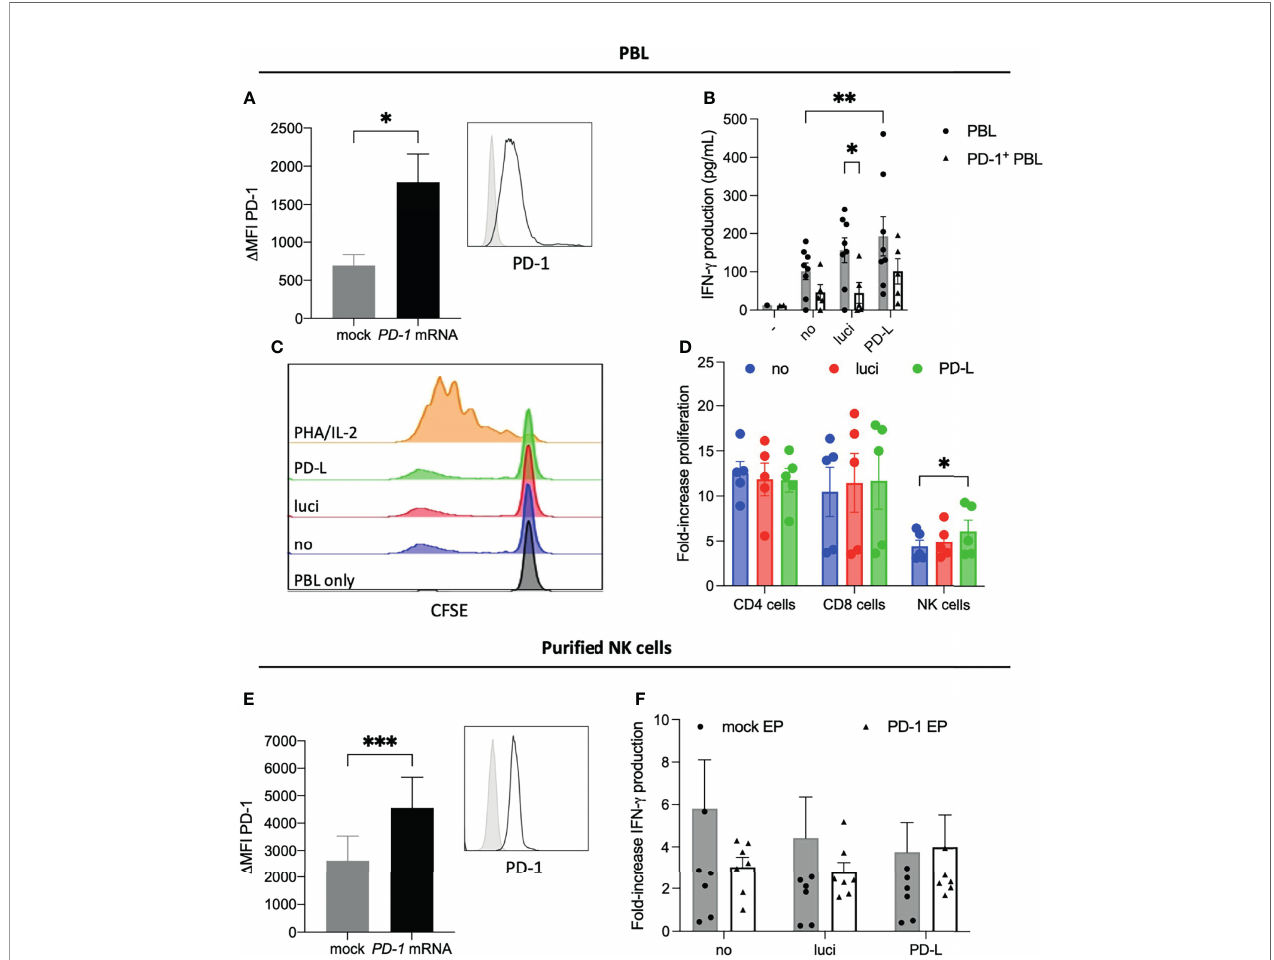
FIGURE 3 | Stimulatory effect of siRNA engineered IL-15 DCs on primary human effector cells. (A) Mean fl uorescence intensity of PD-1 surface expression on viable PBLs 2 hours after mock and PD-1 mRNA electroporation (n = 3). Inset represents histogram overlay of PD-1 expression over isotype control ( fi lled histogram). (B – D) Allo-stimulatory capacity of untreated (no), control siRNA (luci) or PD-L siRNA IL-15 DCs in a 5-day MLR with PBL (mock; circle symbols) and PD-1 mRNA- electroporated PBL (PD-1 + PBL; triangle symbols). (B) Concentration IFN- g in cell-free culture supernatant after 5 days stimulation (mean ± SEM; n = 9 in 4 independent experiments). (C) Degree of CFSE dilution in total viable PBL fraction is shown for one representative example of 6 donors, including a positive control with PHA/IL-2 and a negative control with unstimulated PBL. (D) Fold-increase of CFSE dilution upon stimulation with IL-15 DCs compared to their respective unstimulated mock- electroporated PBL, among singlet/Aqua live/dead - gated CD3 + CD4 + T cells, CD3 + CD8 + and CD3 - CD56 + NK cells (mean +- SEM, n = 6 in 3 independent experiments). (E) PD-1 expression on puri fi ed mock-electroporated or PD-1 mRNA-electroporated NK cells (n = 8). Histogram shows a representative example of PD-1 expression in mock EP NK cells (grey fi lled histogram) and PD-1 EP NK cells (black un fi lled histogram). (F) Fold-increase in concentration IFN- g in 48h supernatants of cocultures of puri fi ed mock or PD-1 mRNA-electroporated NK cells with autologous no, luci, or PD-L siRNA IL-15 DCs (n = 8). For (A, E) an unpaired t-test was used upon con fi rming normal distribution and homoscedasticity. For (B, D) the non-parametric Friedman test was used, *p < 0.05, ***p < 0.001. CFSE, carboxy fl uorescein succinimidyl ester; EP, electroporation; IFN- g , interferon gamma; MFI, mean fl uorescence intensity; NK cell, natural killer cell; PBL, peripheral blood lymphocytes; PD-1, programmed death-1. **,